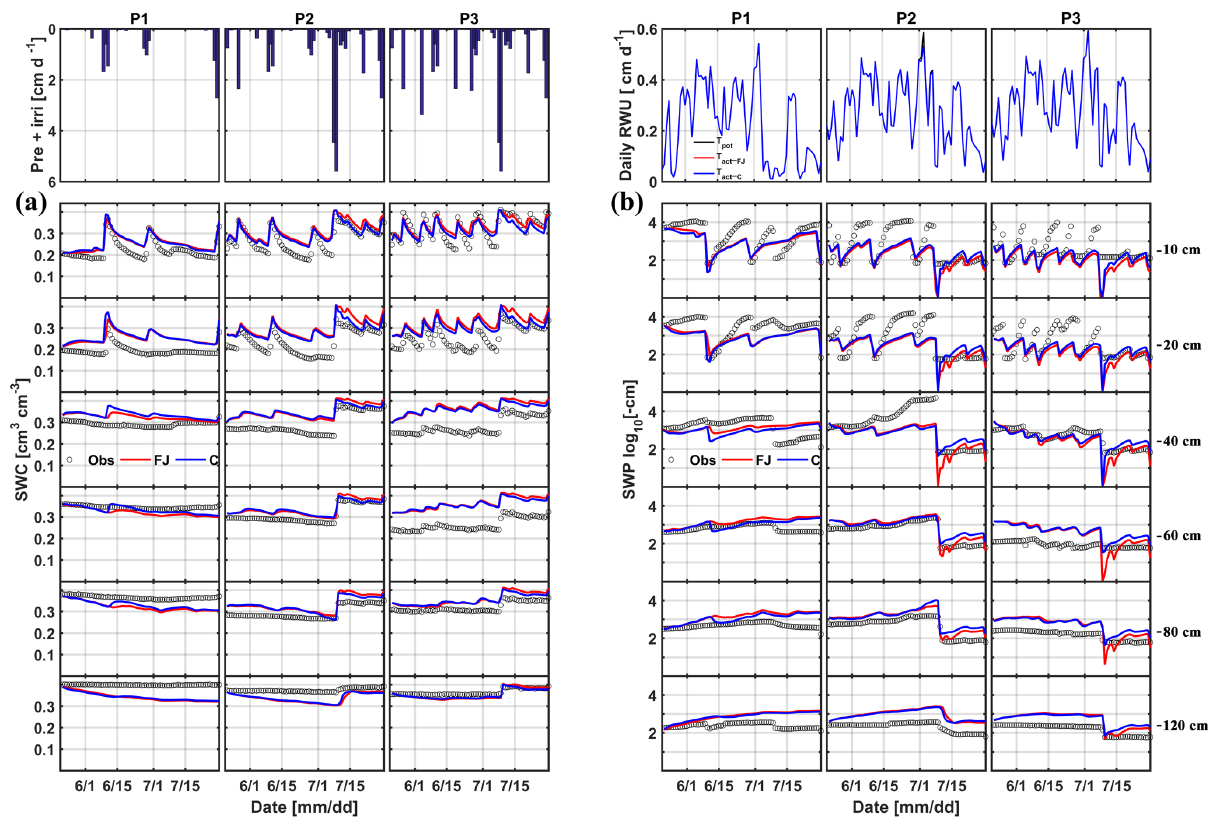
Figure 6. Same as Fig. 5 but for silty soil from 22 May to 30 July 2014.